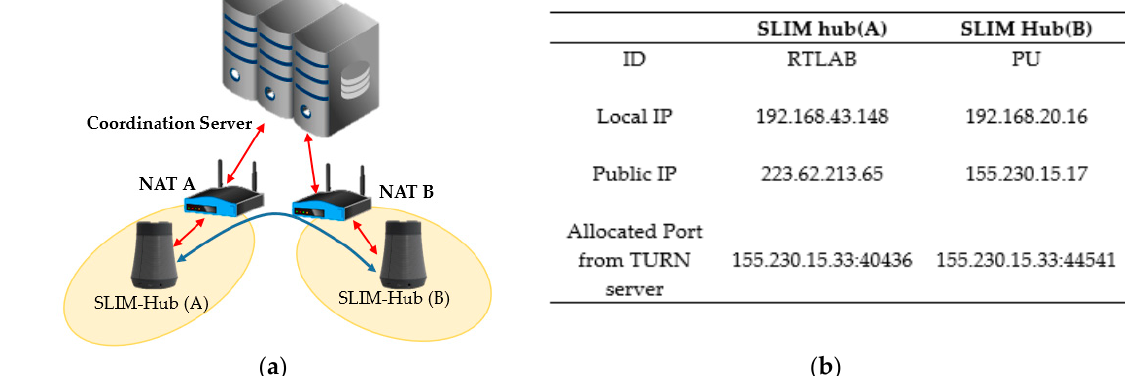
Figure 20. Connectivity checks in same private network. Figure 21. Connectivity environments of different NATs. ( a ) Configuration of experiments; ( b ) A list of SLIM hub’s ID and IP information.